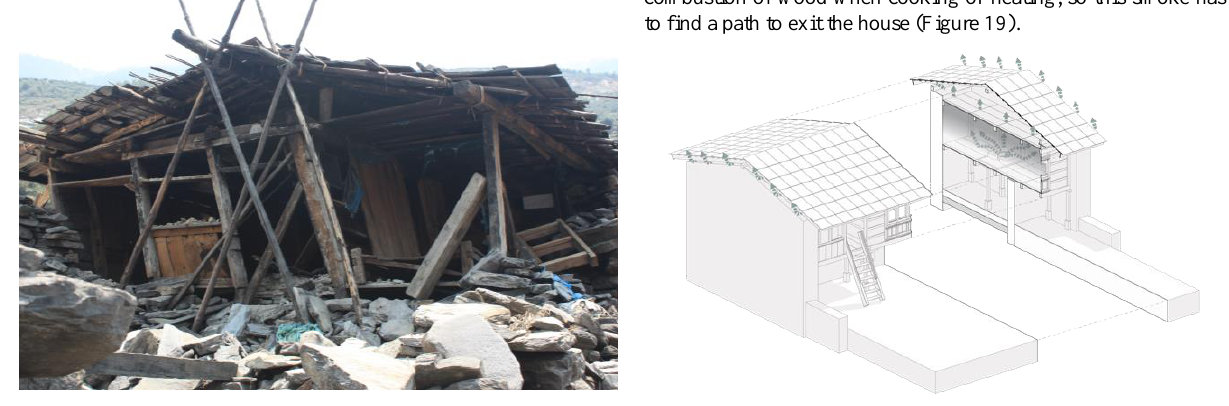
Figure 19. Air flow diagram